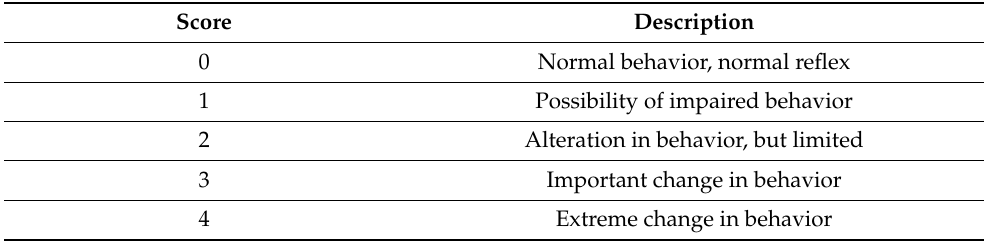
Table 1. Scoring (0–4) used to evaluate vestibular function through the VDR.